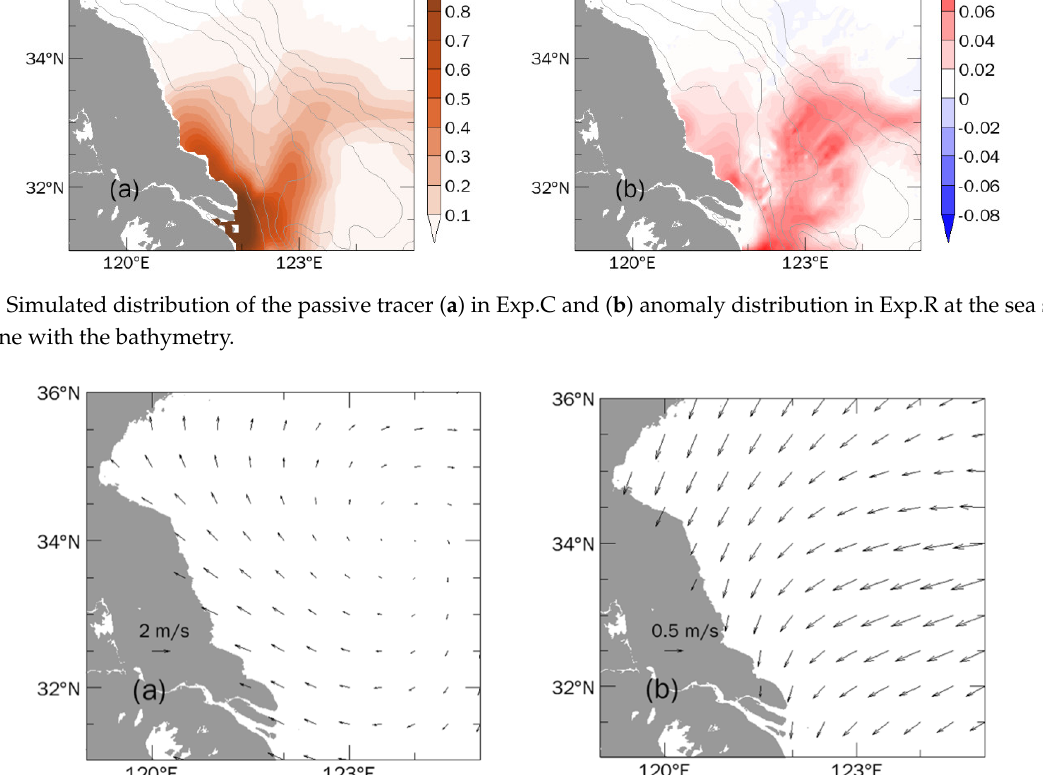
Figure 8. Simulated distribution of the passive tracer ( a ) in Exp.C and ( b ) anomaly distribution in Exp.R at the sea surface in late June with the bathymetry.